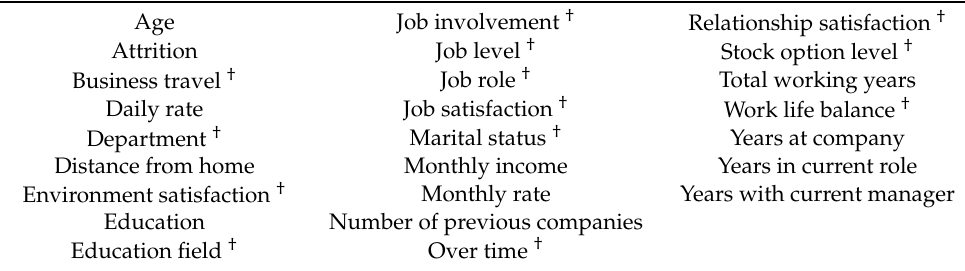
Table 1. Dataset features after features selection. Features marked with † are categorical, while the others are